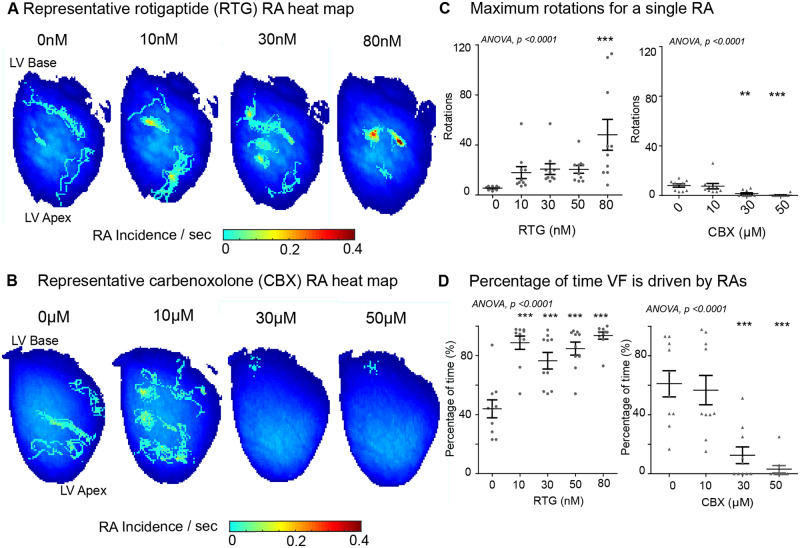
The degree of GJ coupling influences the stability of RAs. Representative RA heat map in (A) RTG- and (B) CBX-treated hearts in VF. (C) Progressive increase in maximum rotations for a single RA in RTG group in comparison to decrease with CBX. (D) Increase in percentage of VF time driven by RAs at increasing RTG concentrations comparative to decrease with CBX. Data from RTG (n = 10) and CBX (n = 10) hearts. Statistical analysis with repeated measures ANOVA, post hoc Bonferroni, P-values are in comparison to baseline, **P < 0.01 and ***P < 0.001.